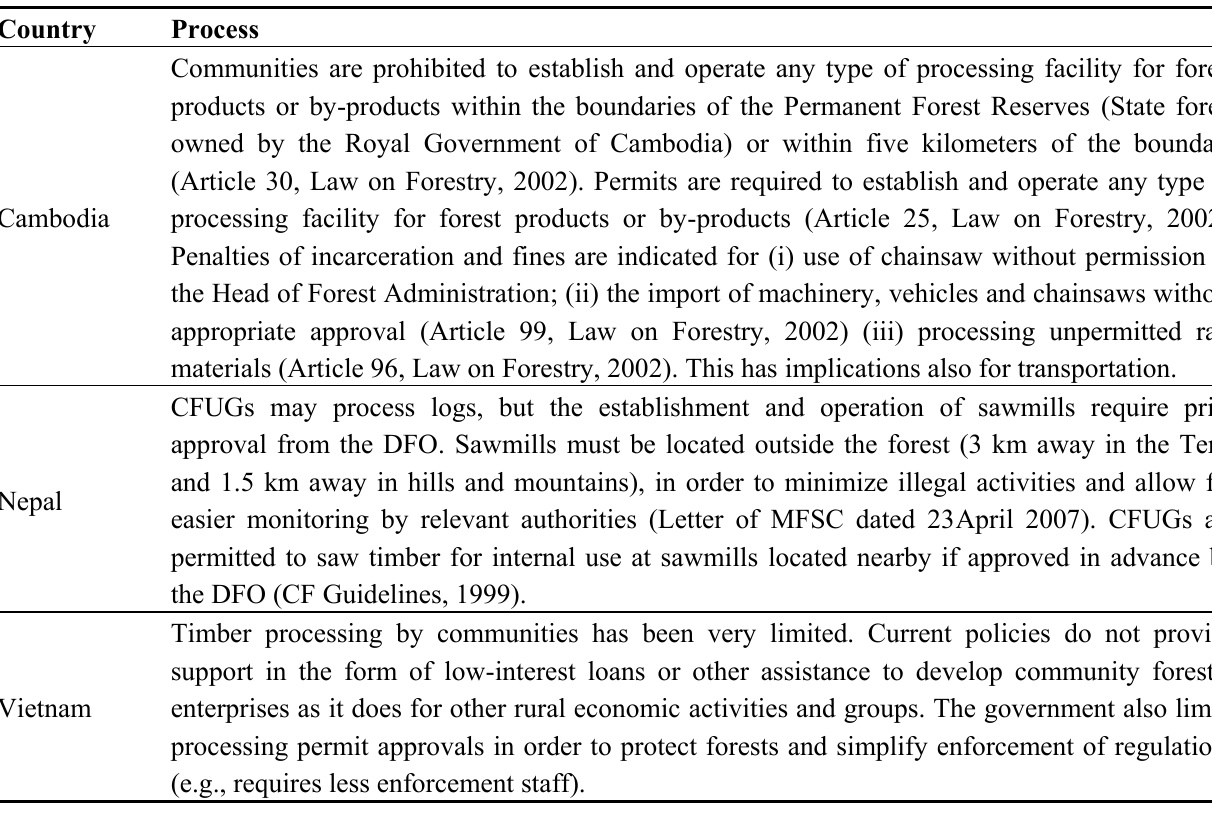
Table 6. Details of requirements for processing timber harvested from community forests in each country